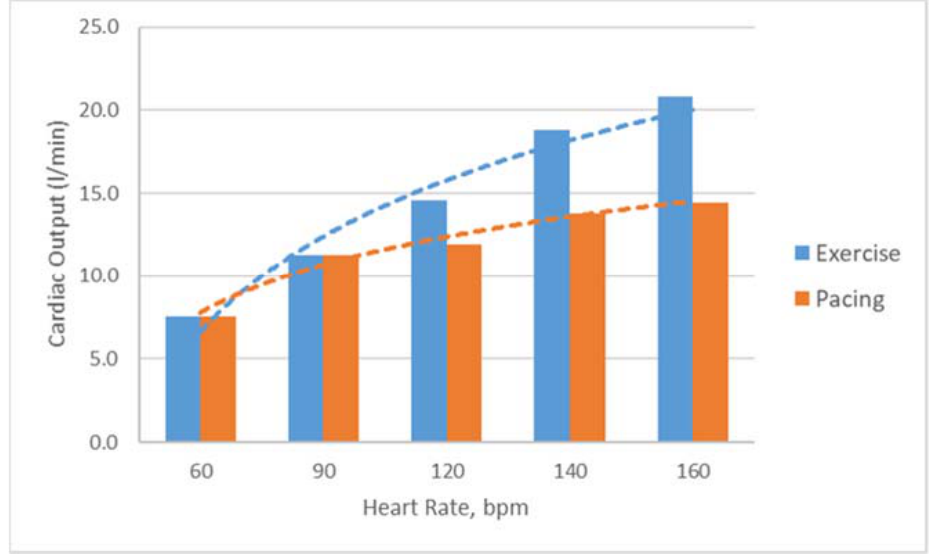
Figure 6. Predictions of cardiac outputs for hearts during exercise and pacing for heart rates of 60, 90, 120, 140 and 160 bpm.